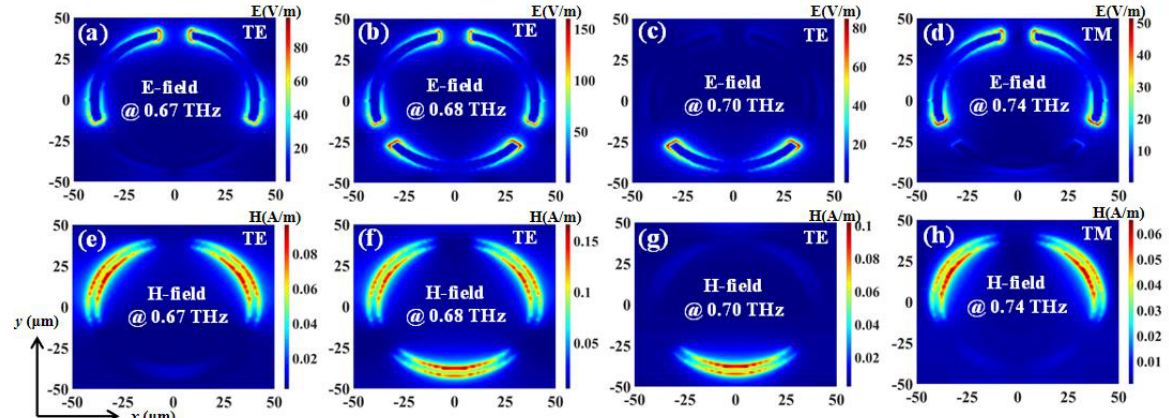
Figure 5. Field distributions of eSRR with R = 40 μm in TE and TM modes. ( a – d ) are E-field distributions. ( e – h ) are H-field distributions.